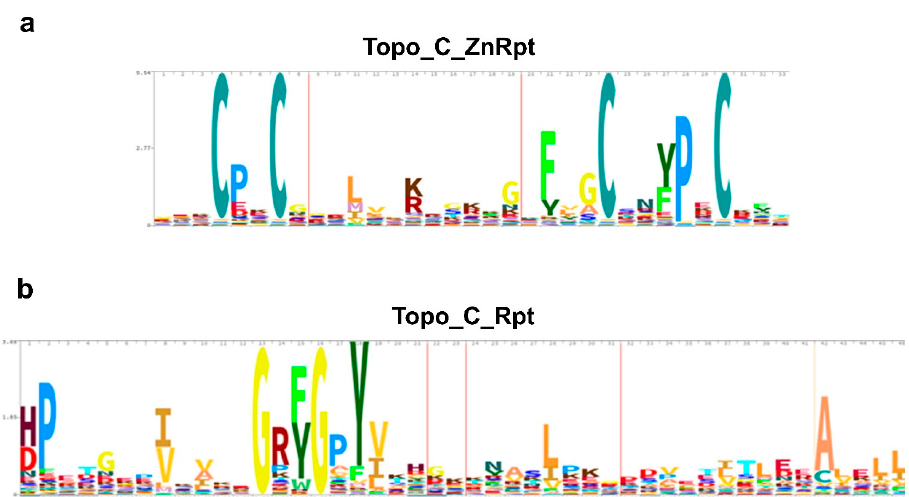
Figure 2. HMM logos for bacterial topoisomerase I C-terminal repeats. ( a ) Topo_C_ZnRpt (Pfam01396 with 14,012 sequences); ( b ) Topo_C_Rpt (Pfam13368 with 14,232 sequences).